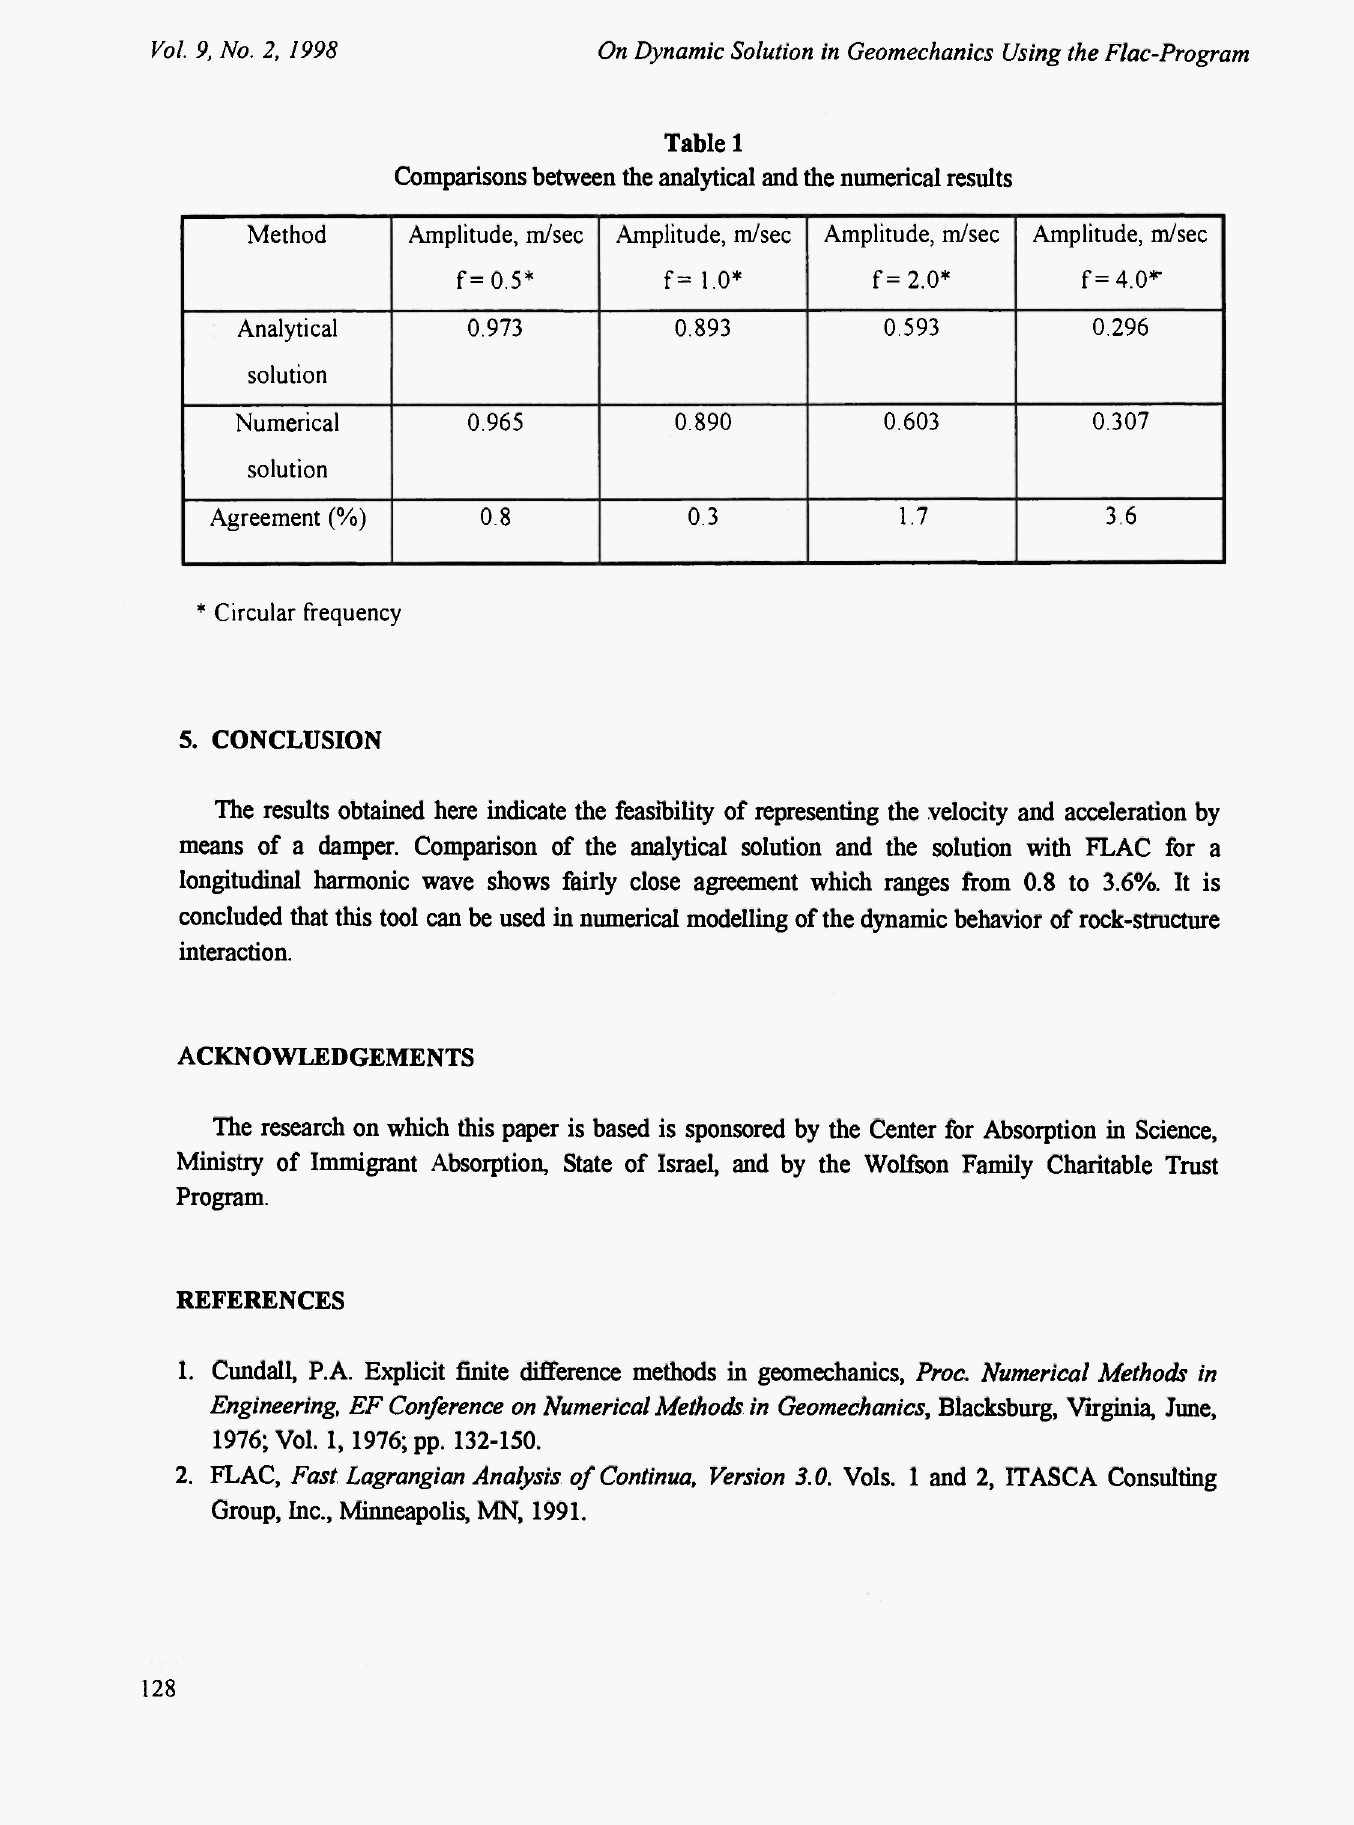
Comparisons between the analytical and the numerical